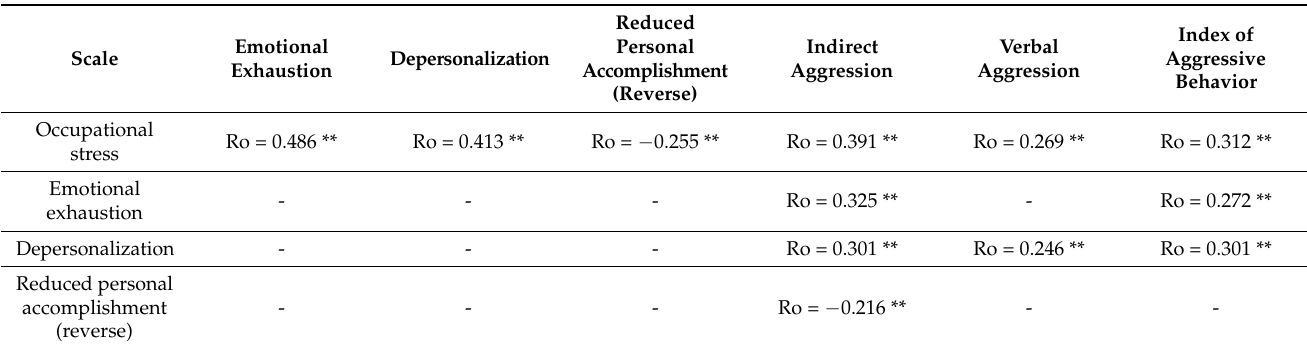
Table 5. Correlation analysis (Ro–Spearman) of occupational burnout, aggression, and occupational stress in non-COVID-19 ICU HCWs.